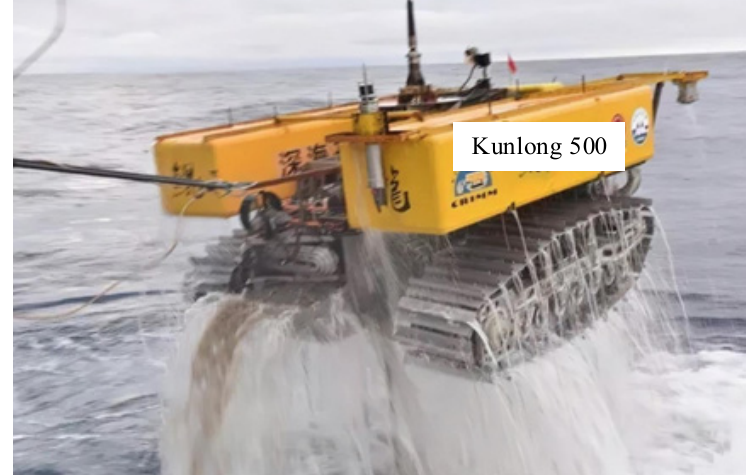
Figure 10. Kunlong 500 [20]. Table 2. Parameters of Kunlong 500 [20].